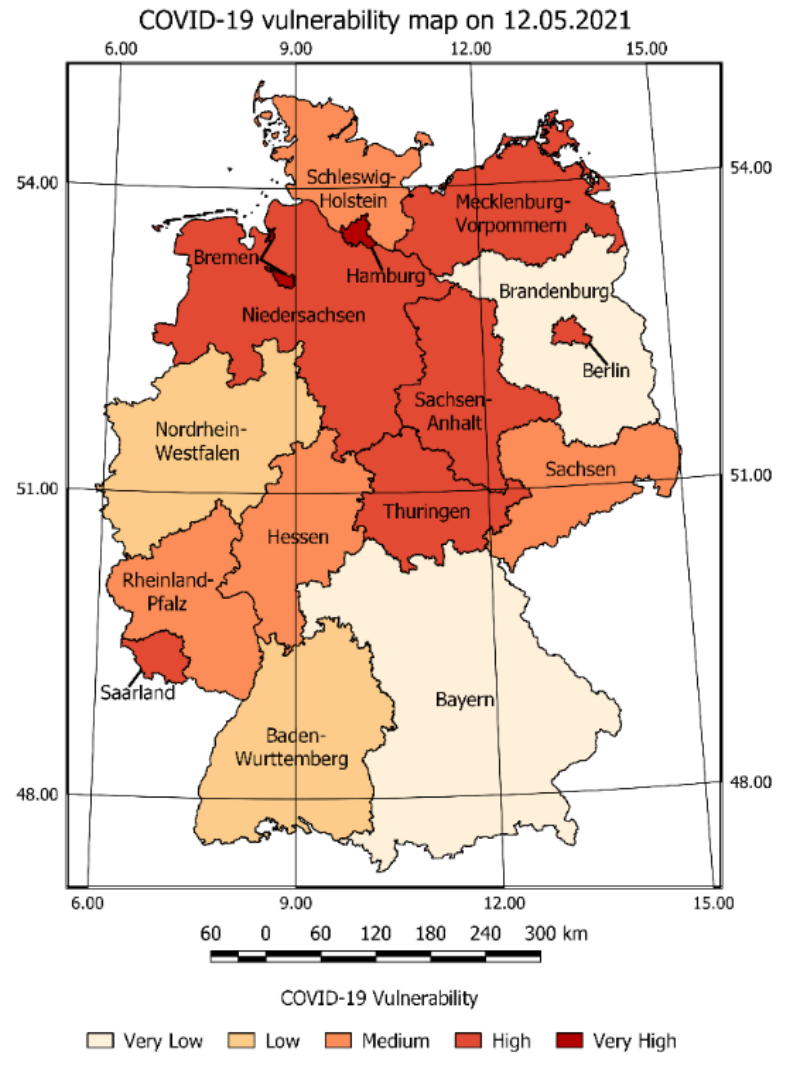
Figure 7. COVID-19 Vulnerability risk map.